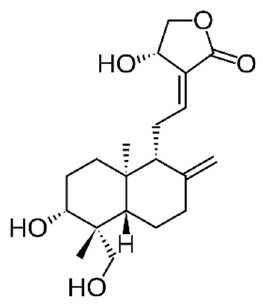
Figure 1. Chemical structure of andrographolide.